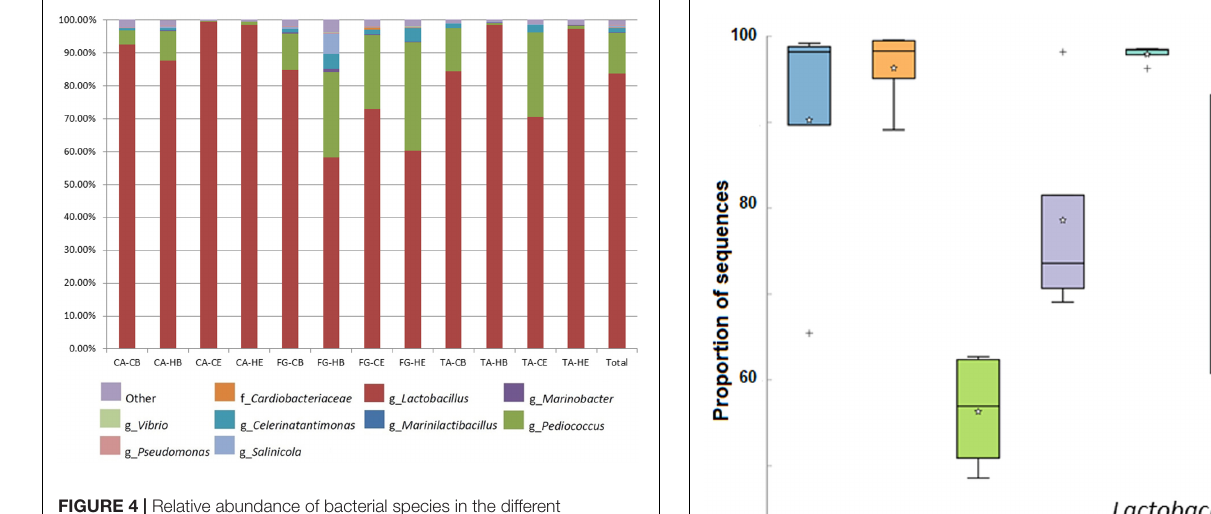
FIGURE 4 | Relative abundance of bacterial species in the different treatments assayed, obtained through metagenomics analysis of 16S RNA gene at the end of the fermentation process in brine (B) and epidermis of fruits (E). CA-C, cured control; CA-H, heat-shocked cured olives; FG-C, refrigerated fresh green control; FG-H, heat-shocked refrigerated fresh green olives; TA-C, control of traditional olives; and TA-H, heat-shocked traditional olives. All treatments were applied to the Aloreña de Malaga cultivar.